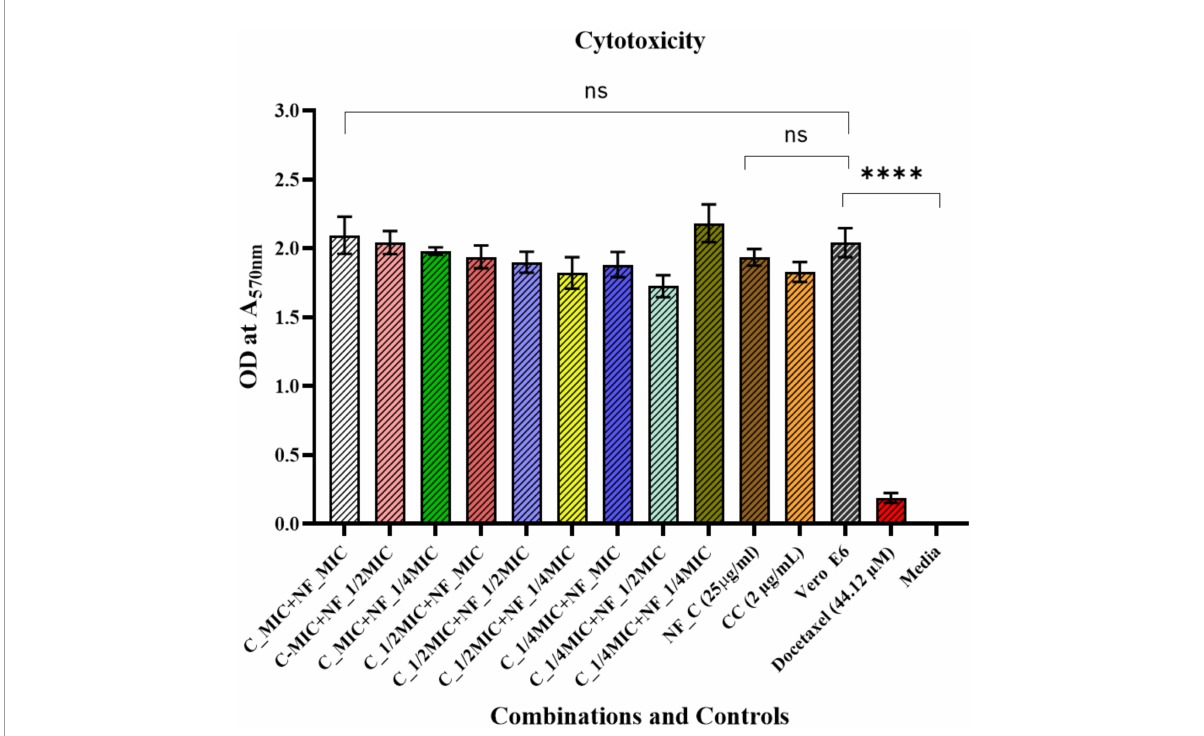
FIGURE6 Cytotoxicity assay: A comparison between untreated Vero E6 Cells against treatment with different combinations of AD-L@Ag(0) and colistin is shown here. The X -axis represents various combinations of colistin and AD-L@Ag(0), along with colistin control (CC), AD-L@Ag(0) control (NF–C), untreated Vero E6 cells, positive control (Docetaxel),and the Y -axis represents the OD values at 570 nm. Results show that there is no significant cytotoxicity found in the case of colistin 1 / 2 MIC and AD-L@Ag(0) 1 / 4 MIC concentration. This is the best combination for potentiation because, at this concentration, it shows less or negligible cytotoxicity to mammalian cells and also demonstrates significant bactericidal effect on colistin-resistant Acinetobacter baumannii . **** Shows the significant difference between Live Vero E6 Control and Cytotoxic Drug treated Vero E6 cells (Cytotoxicity